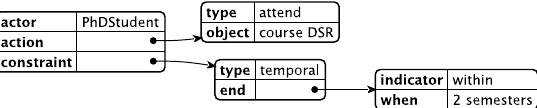
Figure 1: “Core courses” regulation represented through the generic rule model